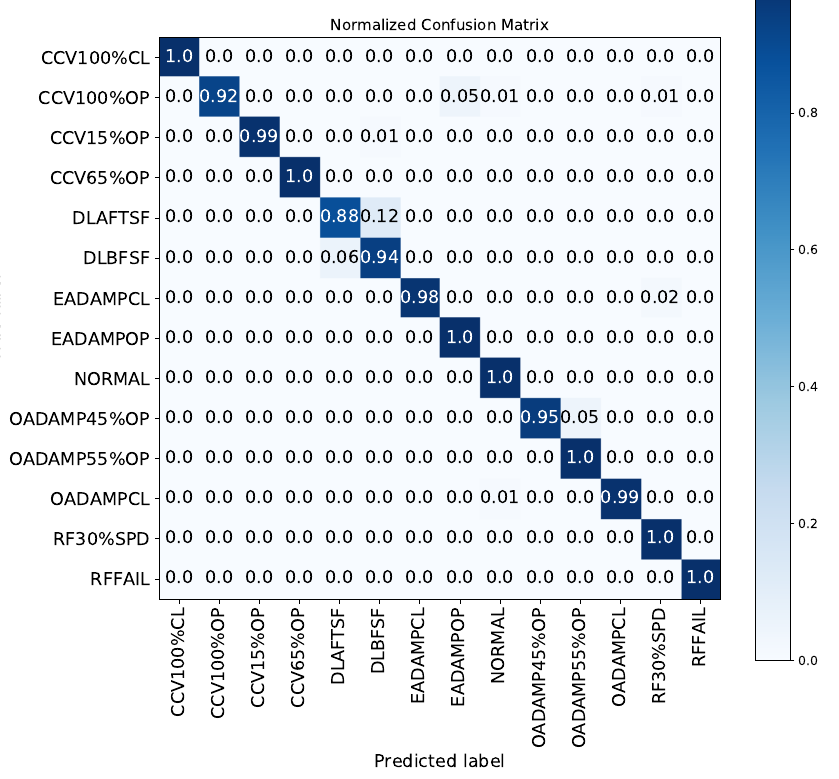
Figure 7. Confusion matrix for proposed HRF–SVM FDD